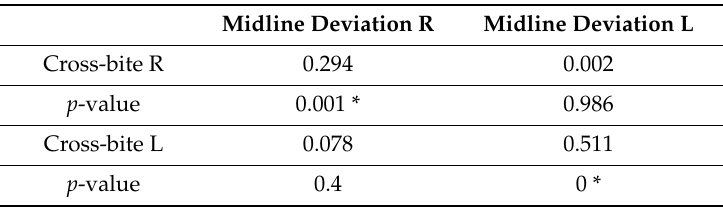
Table 9. Relations between cross-bites and midline deviations in our study. *: p < 0.05, statistically